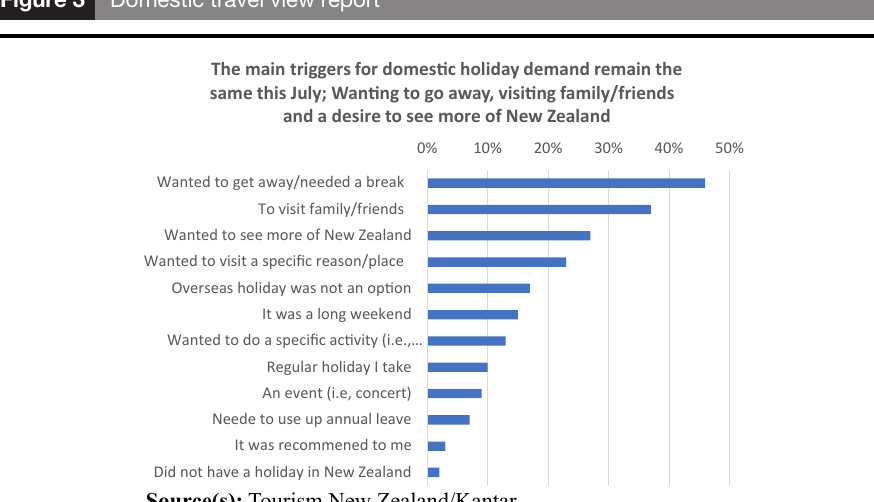
Domestic travel view